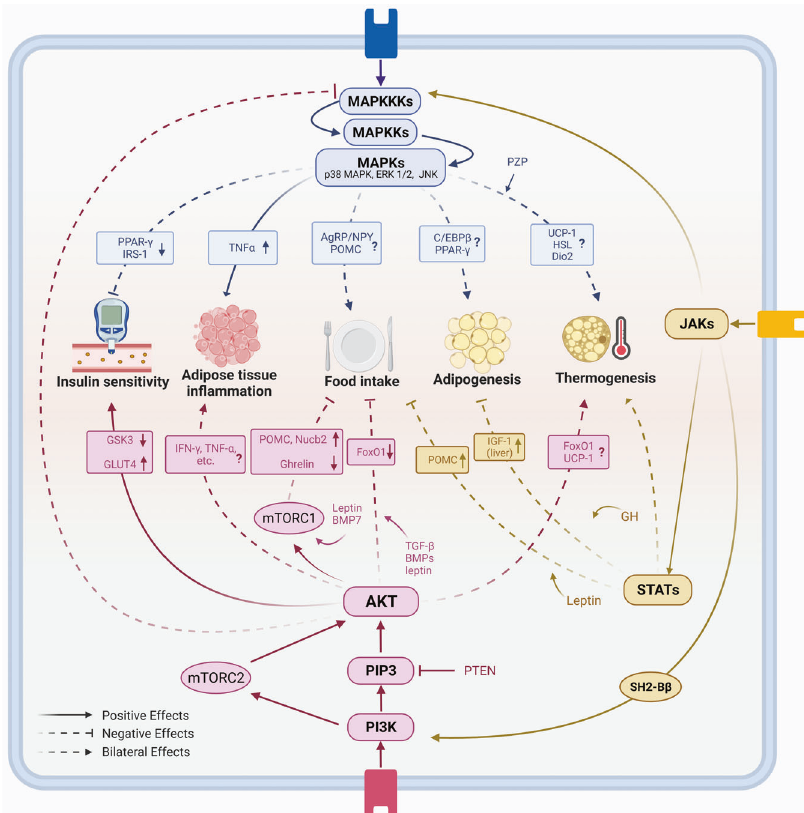
Fig. 2 MAPK, PI3K, and JAK/STAT signaling pathways in obesity pathogenesis. MAPK signaling pathway includes a three-tiered kinase cascade consisting of MAPK kinase kinases (MAPKKKs), MAPK kinases (MAPKKs), and MAPKs. MAPKs such as ERK1/2, JNK, and p38 MAPK play complicated roles in adipogenesis and appetite regulation. Activation of MAPKs induced adipose tissue in fl ammation in obesity. MAPKs also cause insulin resistance in obesity by inactivating IRS1 directly and PPAR- γ indirectly. MAPKs signaling pathway plays diverse roles in adipose tissue browning and thermogenesis. PI3K-AKT pathway is closely related to insulin signaling. It increases GLUT4 and downregulates GSK3, resulting in insulin effects. PI3K-AKT signaling in lymphoid cells reduces adipose tissue in fl ammation to fi ght against obesity, while it results in the opposite direction in myeloid cells. Besides, PI3K-AKT-mTOR signaling negatively regulates food intake and has a bidirectional effect on thermogenesis. JAK-STAT signaling pathway consists of JAK1, 2, and 3, and STAT family includes STAT1, 2, 3, 4, 5a, 5b, and 6. JAKs cannot only activate STATs, but also MAPKKKs and PI3K. JAK-STAT pathway participates in leptin-mediated anorectic effects. In the liver, the activation of JAK-STAT signaling is negatively related to the accumulation of fat. Notably, there are different impacts from different JAKs and STATs on